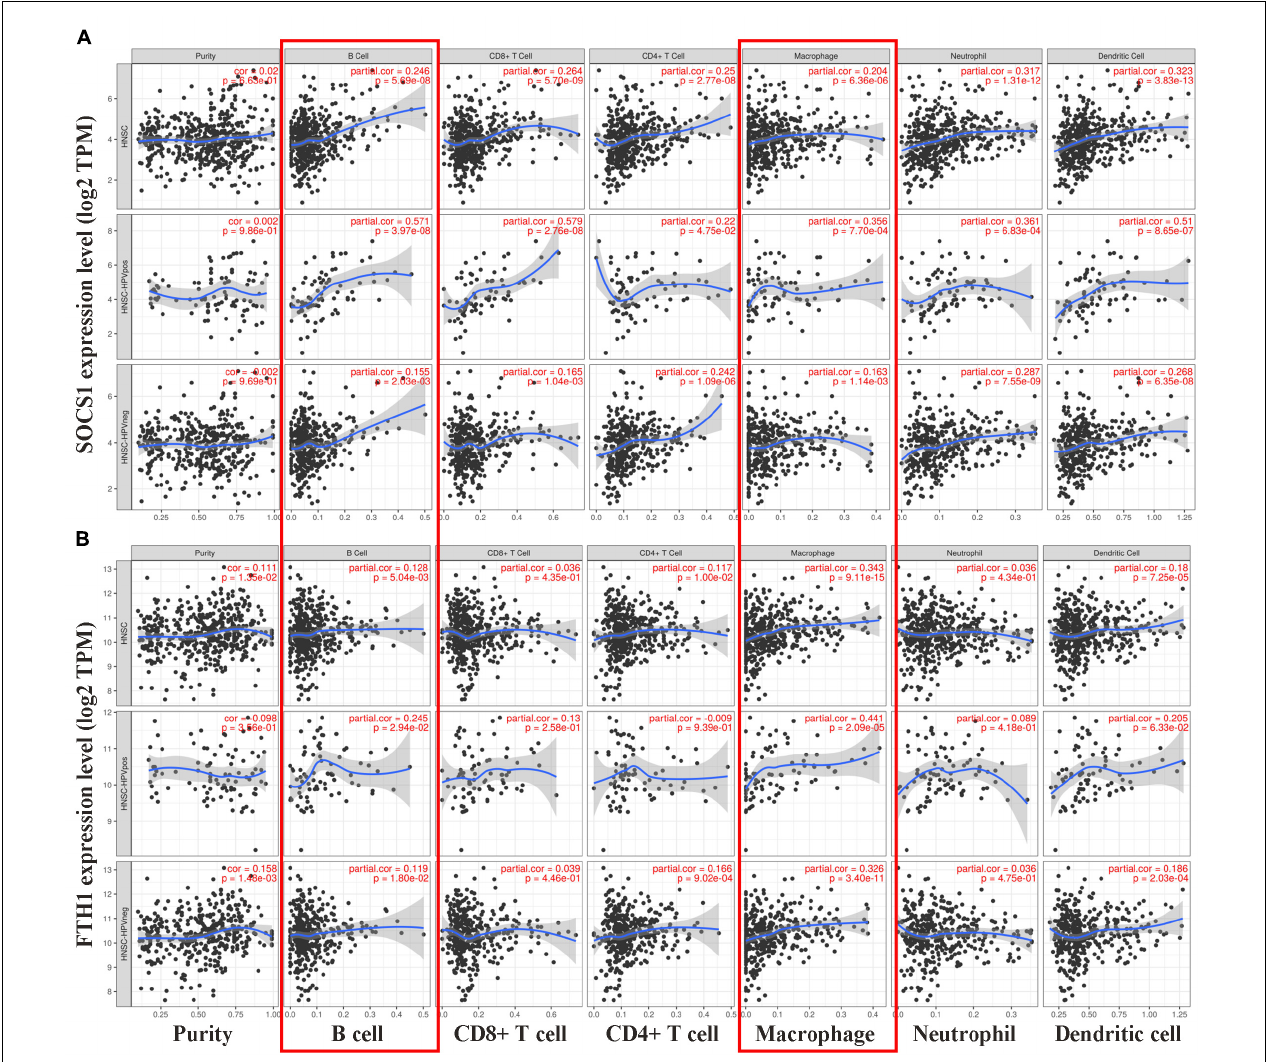
FIGURE 5 | Correlations between SOCS1 and FTH1 expression and immune cell infiltration in HNSCC (TIMER). (A) SOCS1 mRNA levels positively correlated with B cell and macrophage infiltration, independent of HPV status ( SOCS1 and B cells, R = 0.246, p = 5.69 × 10 − 8 ; SOCS1 and macrophages, R = 0.204, p = 6.36 × 10 − 6 ). (B) FTH1 mRNA levels positively correlated with B cell and macrophage infiltration, independent of HPV status ( FTH1 and B cells, R = 0.128, p = 5.04 × 10 − 3 ; FTH1 and macrophages, R = 0.343, p = 9.11 × 10 − 5 ).